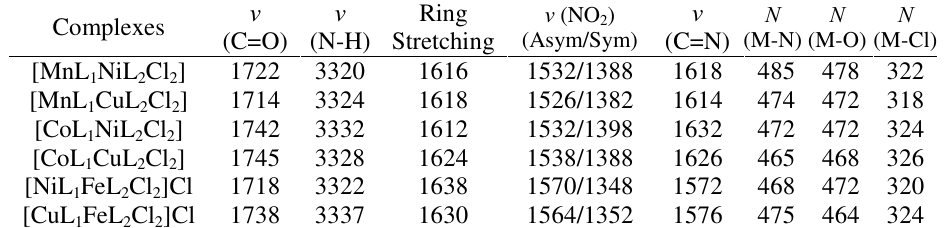
Table 2. IR Spectral data, cm -1 of the heterobinuclear complexes